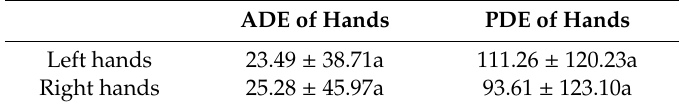
Table 4. Exposure levels of hands (mg / kg a.i.